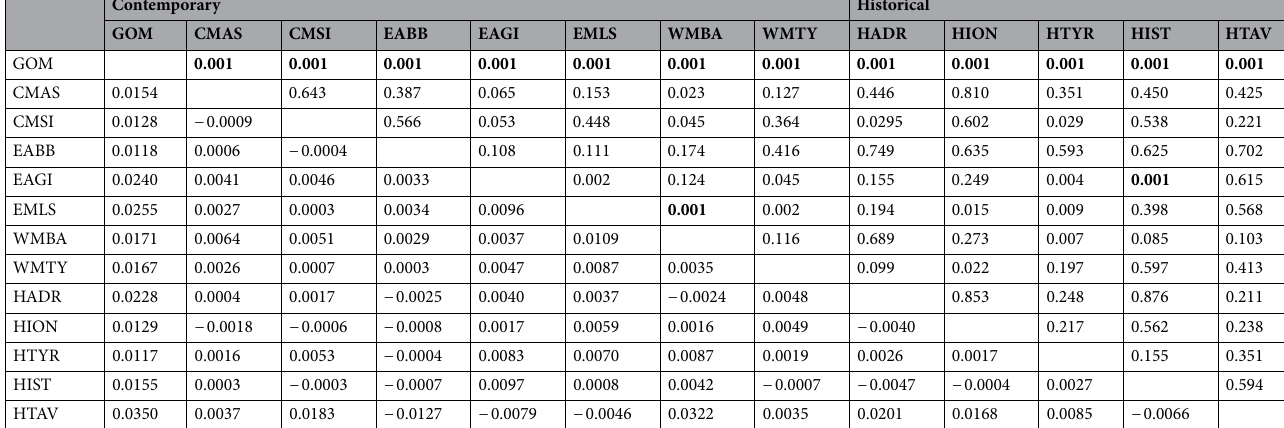
Table 4. Pairwise F ST (below the diagonal) and non-corrected P values (above the diagonal) between contemporary and historical sample groups. p values that were significant after FDR correction are presented in